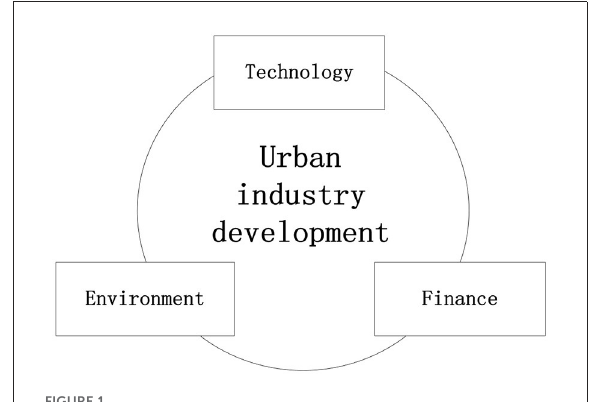
FIGURE1 The PPM framework of the